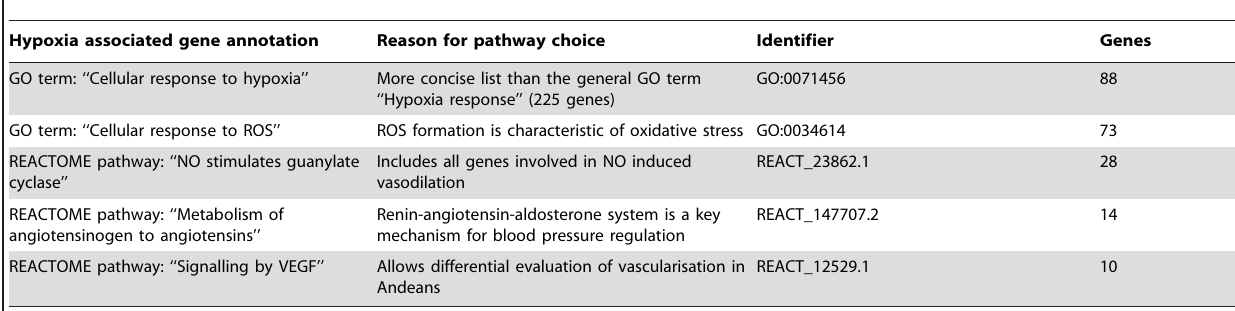
Table 1. Pathways determining hypoxia candidate genes for this study.